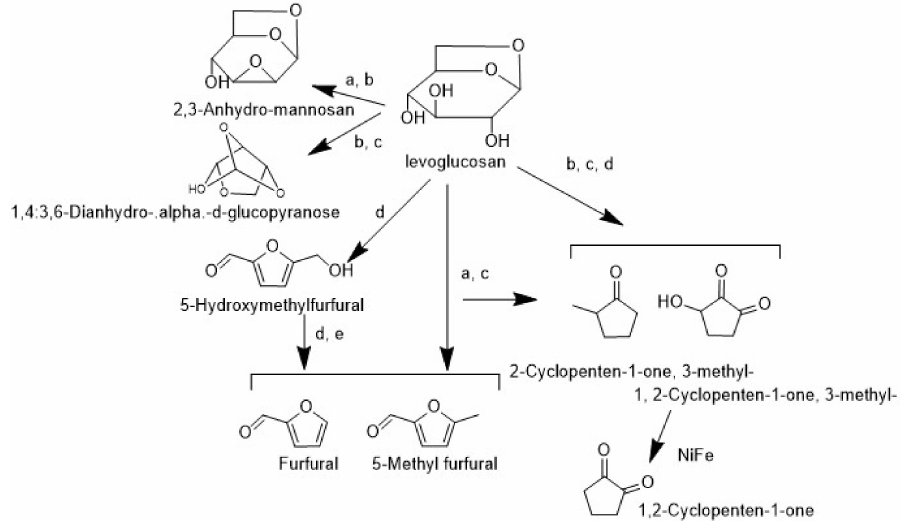
Figure 9. Possible reaction pathways for levoglucosan (sugar) conversion with NiFe cluster